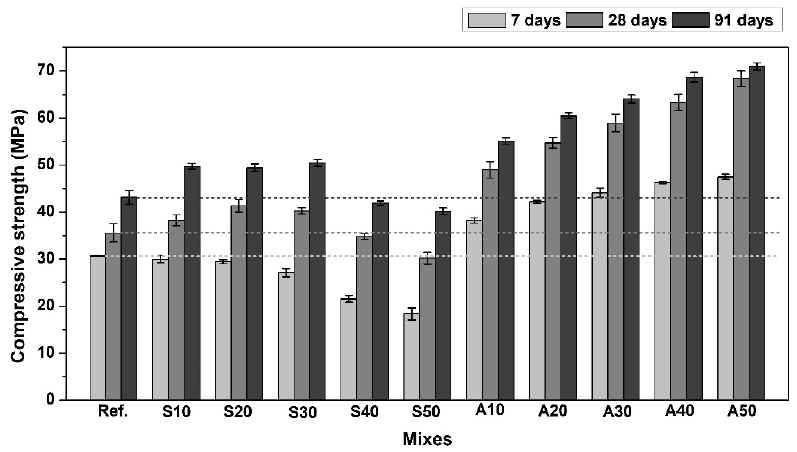
Figure 5. Compressive strength of the concretes.